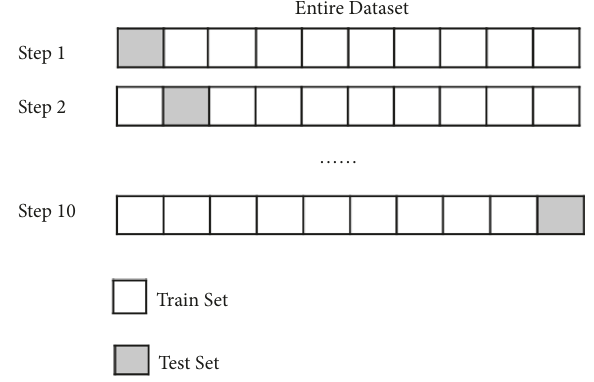
Figure 4: The 10 -fold cross-validation